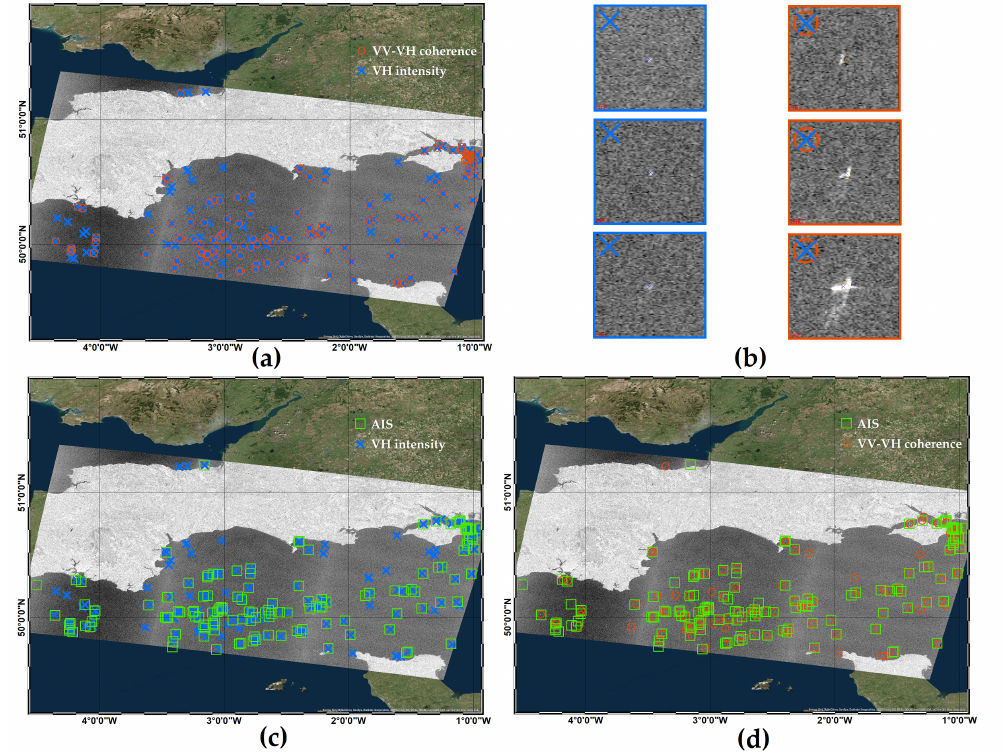
Figure 3. Illustration of the AIS-SAR cross-comparison for a Sentinel-1 IW image acquired over the English Channel area (24/10/2017): ( a ) Vessels detected by the C un − norm -based detector and the CFAR VV − VH applied to I VH , ( b ) signatures of vessels detected by only constant false alarm rate (CFAR) I VH (left column) and by both C un − norm -based detector and CFAR I VH (right column), ( c ) vessels detected by VV − VH the C un − norm -based detector and AIS interpolated positions, ( d ) vessels detected by CFAR applied to VV − VH I VH and AIS interpolated